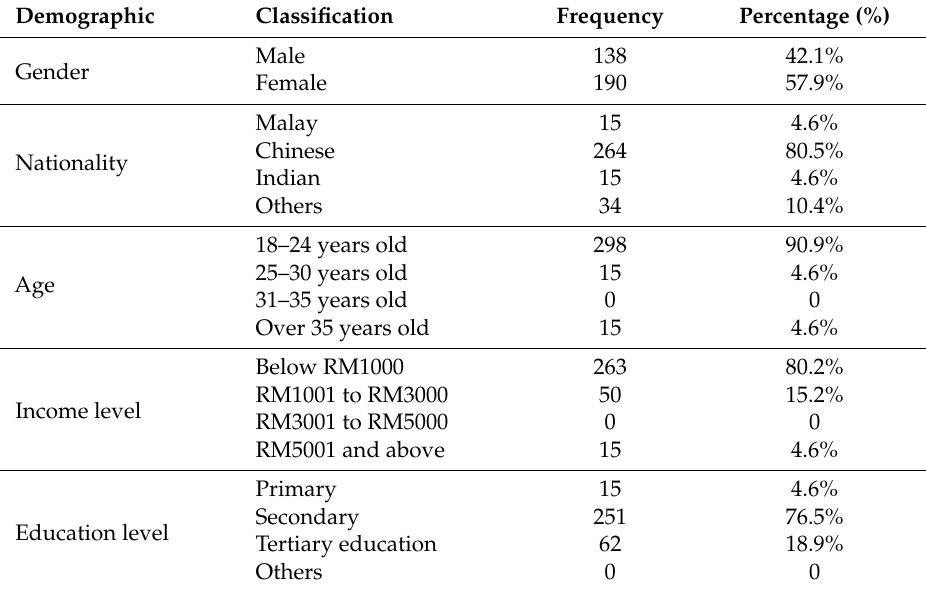
Table 2. Summary of Demographic